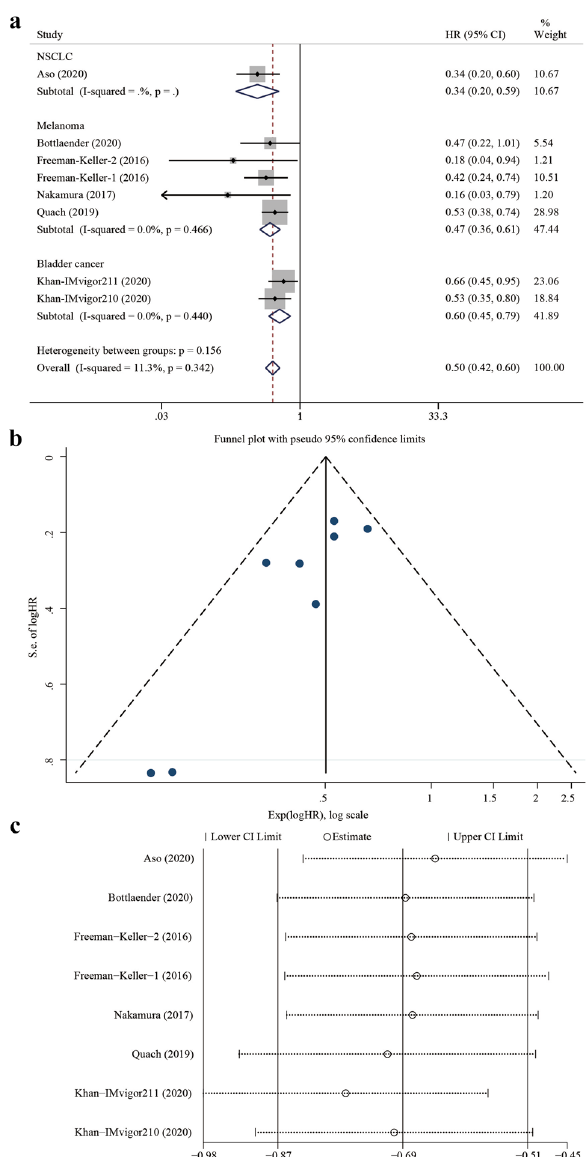
Figure 5. Forest plot showing the association between irCAE occurrence and OS, publication bias analysis, and sensitivity analysis. ( a ) Subgroup analysis among cancer types and OS. ( b ) Funnel plot of the OS. ( c ) Sensitivity analysis of the OS. IrCAEs, immune-related cutaneous adverse events; OS, overall survival; Freeman-Keller-1, OS data for rash; Freeman-Keller-2, OS data for